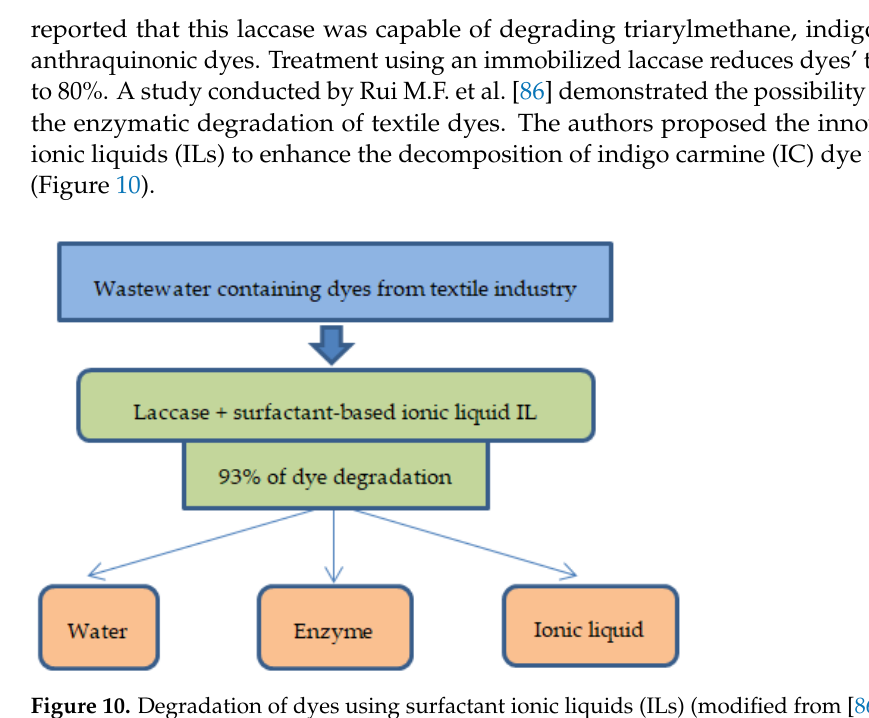
Figure 10. Degradation of dyes using surfactant ionic liquids (ILs) (modified from [86]). It has been shown that the utilization of the decyltrimethylammonium bromide— [N 10111 ]Br is optimal for enzymatic action on dyes. It was significant that in 0.5 h a color removal percentage of 82% was achieved, compared to 6% removal when IL was not been used. After one day of treatment under the same conditions, a decolorization rate of 93% was obtained [86].